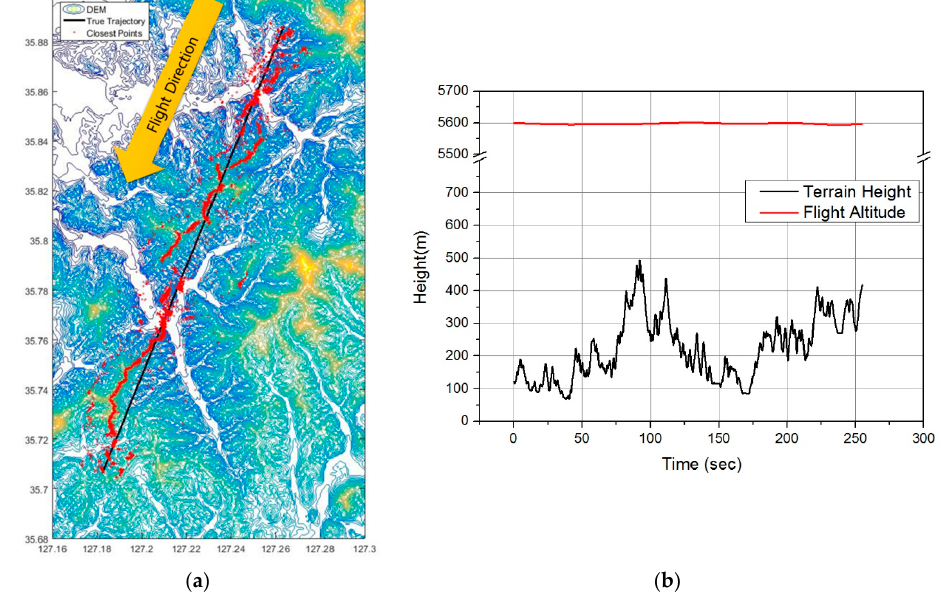
Figure 17. Simulation trajectory: ( a ) horizontal flight trajectory; ( b ) flight altitude and terrain height profile. Table 2. Simulation condition. TRN simulations were performed for four cases to compare the performance di ff erence according to ∆ p k , and the details of the simulation are shown in Table 3. The Monte Carlo (MC) simulation was performed 50 times for statistical error comparisons.